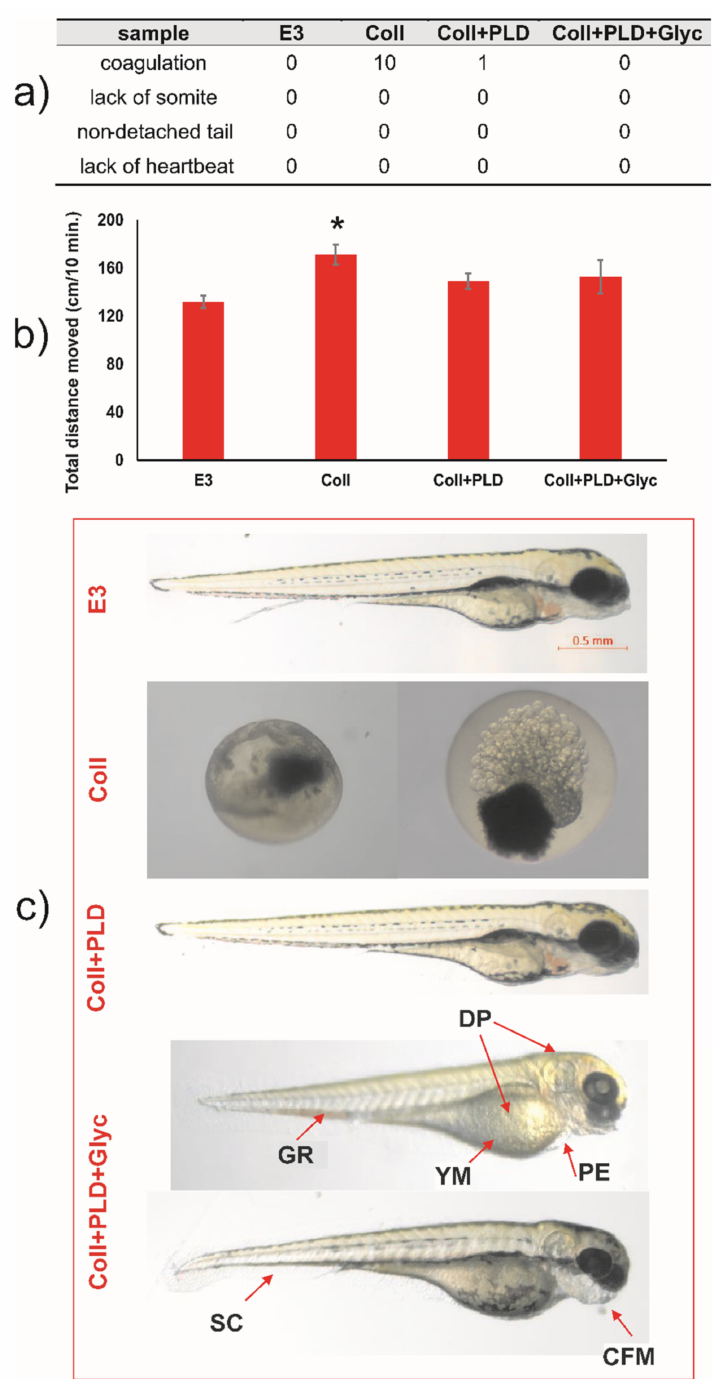
Figure 6. Evaluation of toxic and neurotoxic effect of extracts of Coll, Coll+PLD and Coll+PLD+Glyc grafts in Danio rerio model. ( a ) Apical observation of acute toxicity; ( b ) locomotor activity of 5 dpf (days post-fertilization) zebrafish larvae; ( c ) morphological changes at 96 hpf (hours post-fertilization) zebrafish larvae (SC—spinal curvature, CFM—craniofacial malformation; PE—pericardial oedema; YM—yolk malformation; DP—depigmentation; GR—growth retardation). (*) symbol indicates statistically significant results between control E3 medium and all samples, according to one-way ANOVA with post-hoc Tukey’s test ( p <